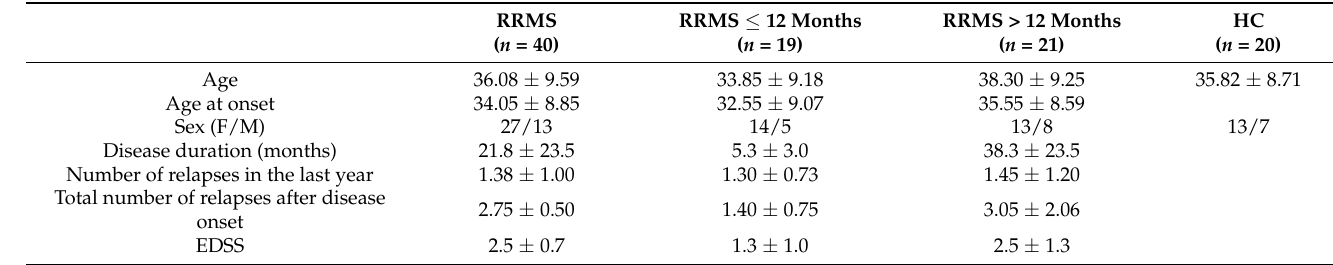
Table 1. Demographic and disease-associated data for naïve RRMS patients and HCs.